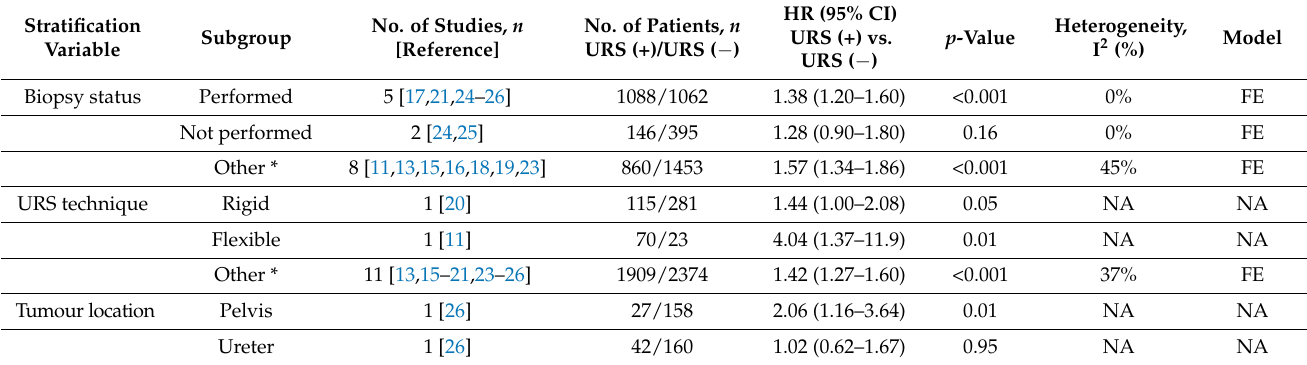
Table 3. Results of exploratory subgroup analyses comparing intravesical recurrence-free survival between URS (+) and URS ( − ) groups, stratified by: biopsy status, URS technique, tumour location, bladder cancer history, bladder cuff excision, receipt of perioperative systemic chemotherapy, receipt of intravesical installation post RNU, and geographical